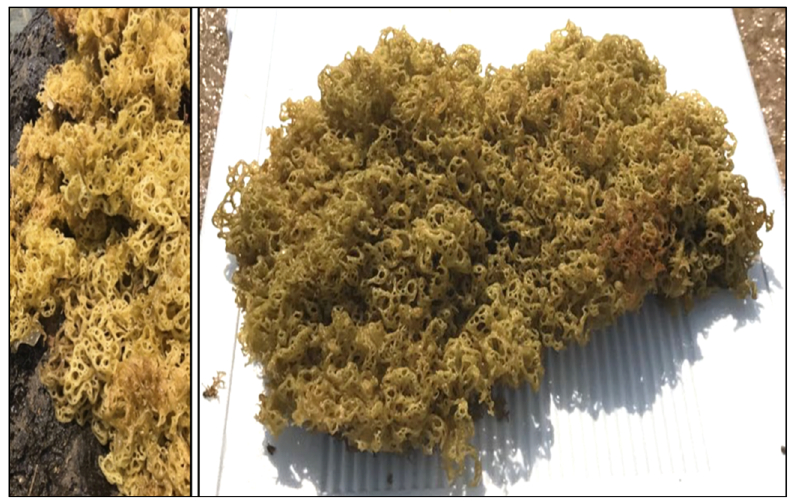
Figure 1: Hydroclathrus clathratus on the collection